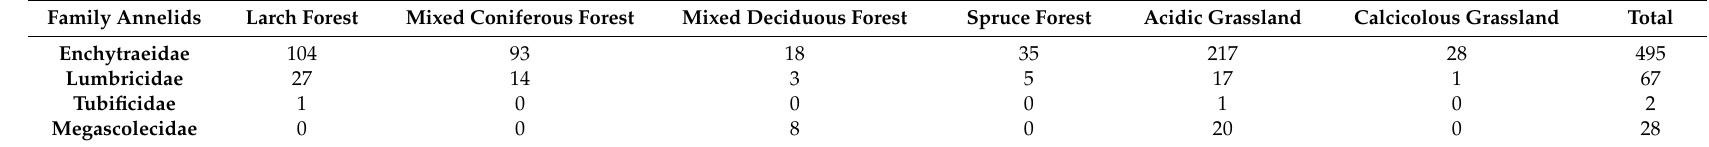
Table 3. Presences of Annelida detected with eDNA